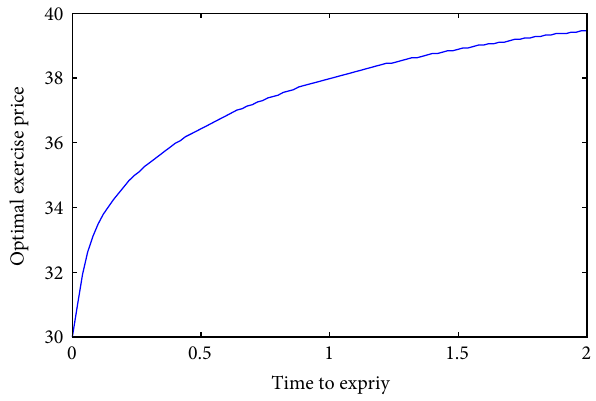
Figure 4: Optimal exercise price exp 𝐶 = 1.13, 𝐺 = 1.1, 𝑀 = 1, 𝑌 = 1.5, 𝑇 = 2, 𝐾 = 50